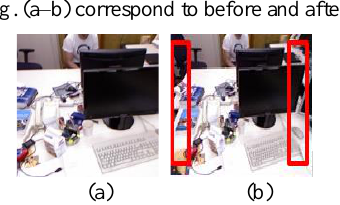
Figure 4 . Field of view comparison between PoseNet and LRF- PoseNet. (a–b) correspond to different